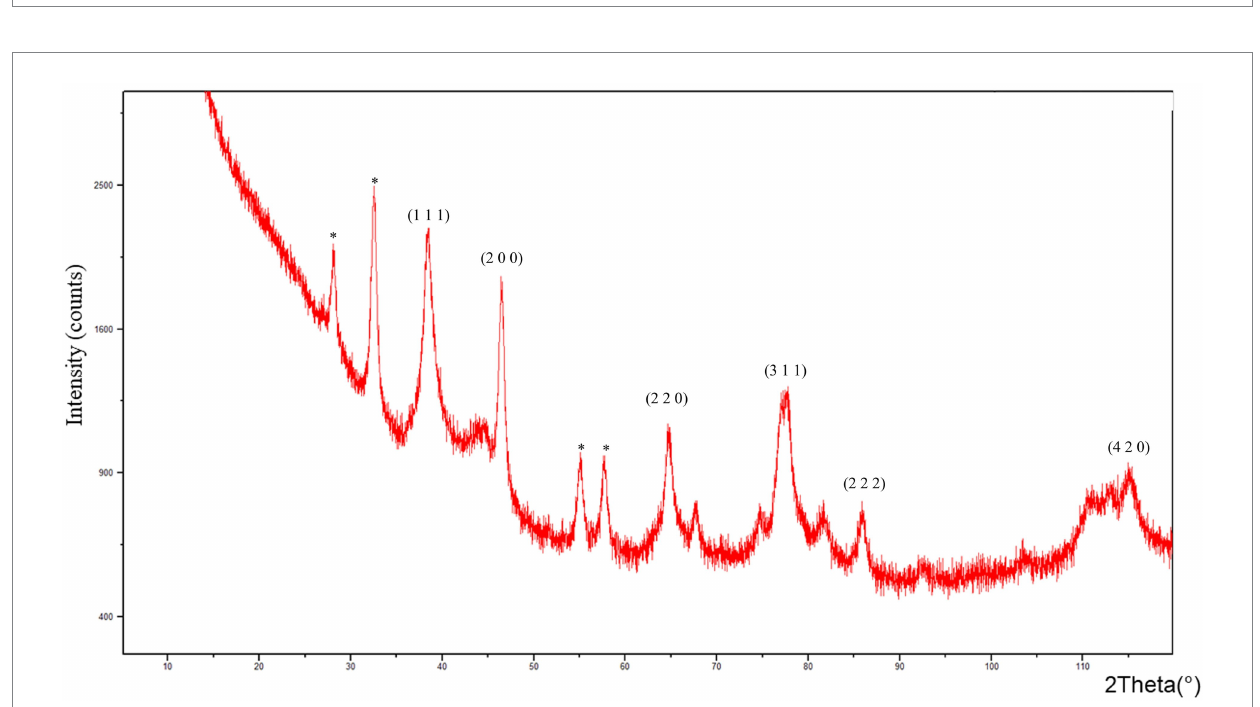
Supplementary Figure S4. The dynamic light scattering